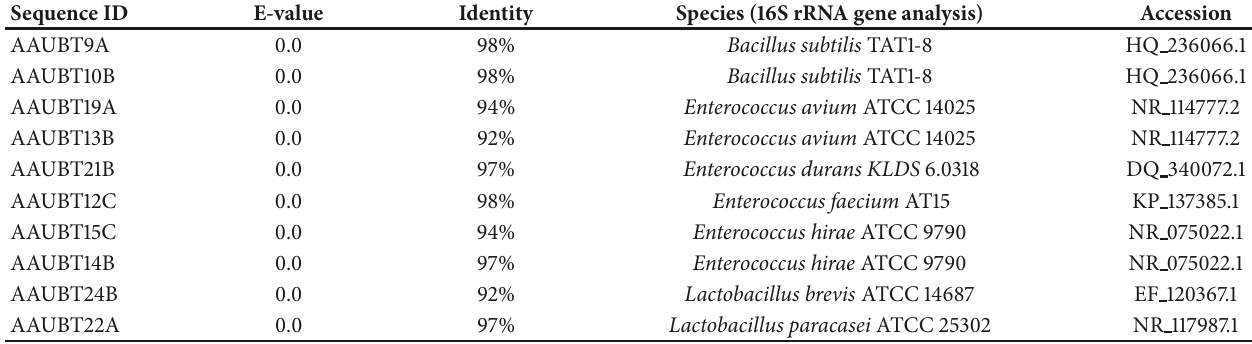
Table 3: Phylogenetic neighbors of bacteria on the basis of similarity to the partial 16S rDNA sequence.